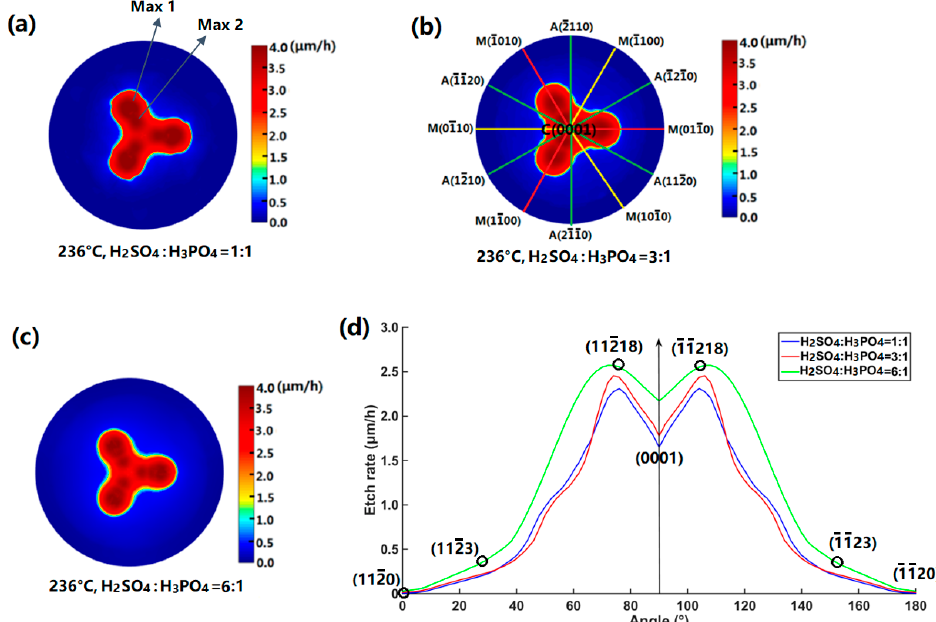
Figure 5. ( a – c ) Etch rate distributions of sapphire under different concentrations (236 °C, H 2 SO 4 :H 3 PO 4 = 1:1, 3:1 and 6:1); ( d ) etch rate in the < − 1 1 0 0> crystal zone under di ff erent concentrations (236 °C, H 2 SO 4 :H 3 PO 4 = 1:1, 3:1 and 6:1). Table 3. Maximum rates (Max 1 and Max 2) at different concentrations (volume ratios of 98 wt% H 2 SO 4 to 87 wt% H 3 PO 4 ).